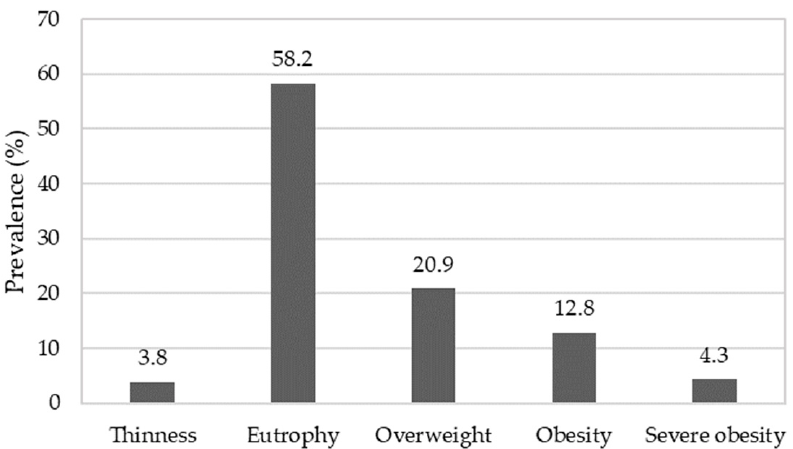
Figure 2. Elementary-school children nutritional status. Thinness— ≥ 0.1st percentile and <3rd percentile; eutrophy— ≥ 3rd percentile and ≤ 85th percentile; overweight—>85th percentile and ≤ 97th percentile; obesity—>97th percentile and ≤ 99.9th percentile; severe obesity—>99.9th percentile.